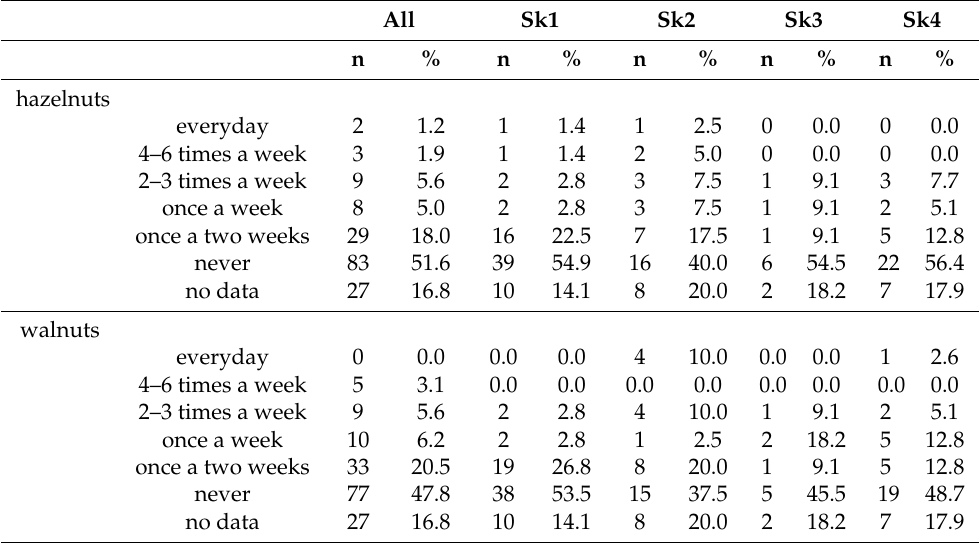
Table A5. Consumption of nuts among investigated